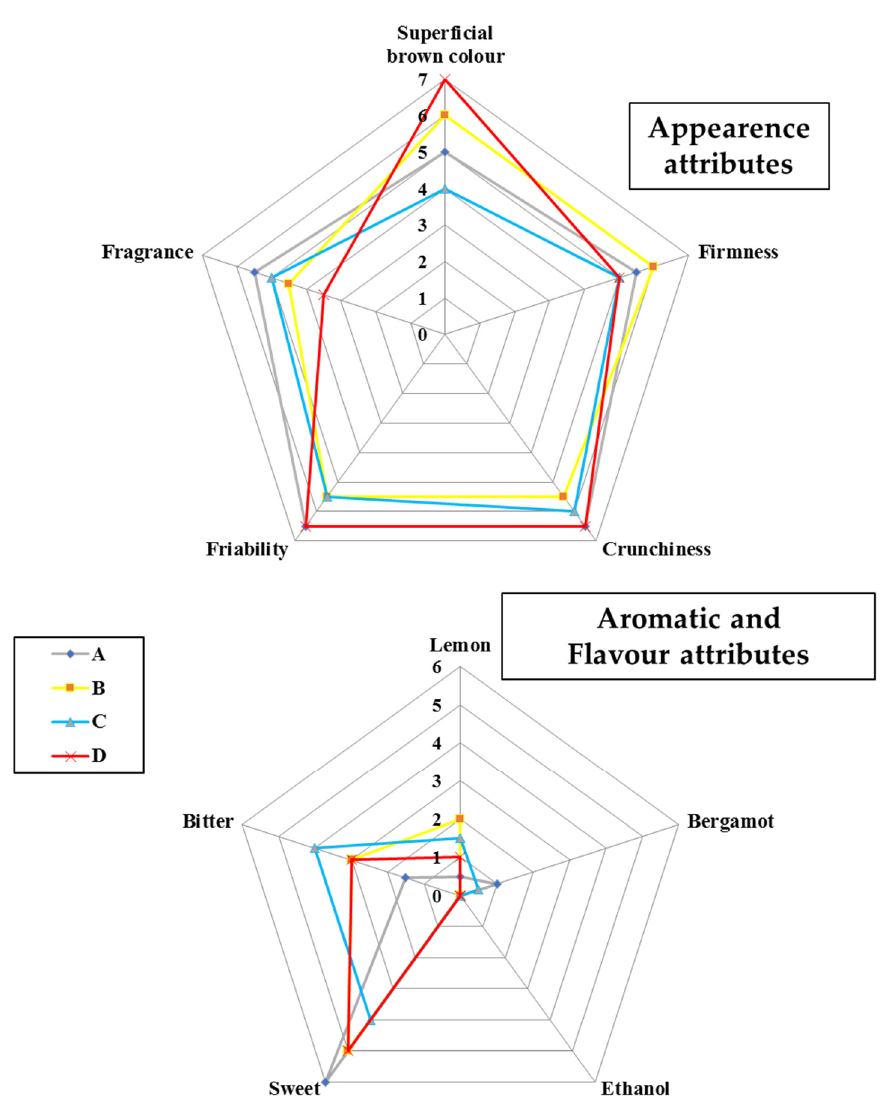
Figure 4. Median values of biscuits sensory evaluation.